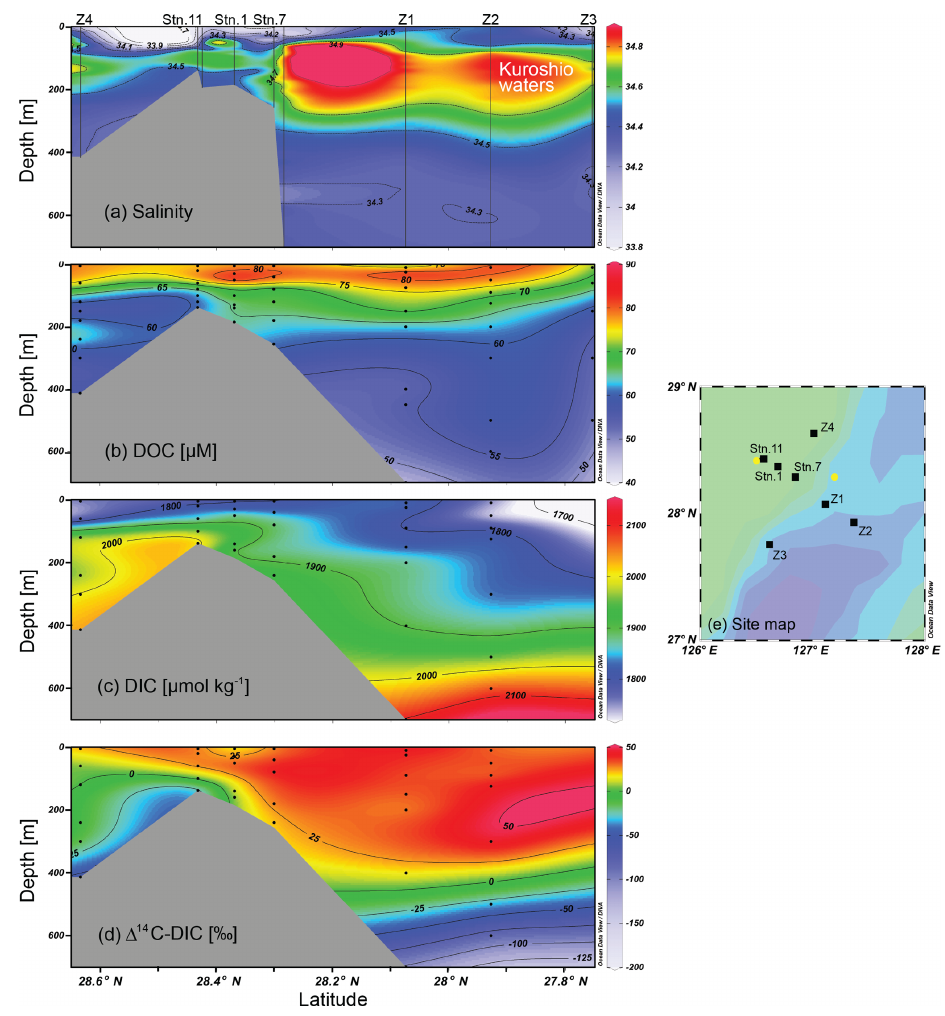
Figure 7. Transectional distributions of (a) salinity, (b) DOC concentrations, (c) DIC concentrations and (d) (cid:49) 14 C-DIC values for the (e) sampling stations (black squares) covering the shelf-edge and slope region of ECS during the cruise in July 2014. Black dots indicate the depths where samples were collected. Note that (a) the salinity of the other two stations (yellow circles) from the cruise in July 2011 is included to support the spreading of the data. (b–d) The distributions of DOC concentrations include seven stations, whereas DIC concen- trations and (cid:49) 14 C-DIC values are given only for six stations due to the lack of data at station Z3 (Ge et al.,